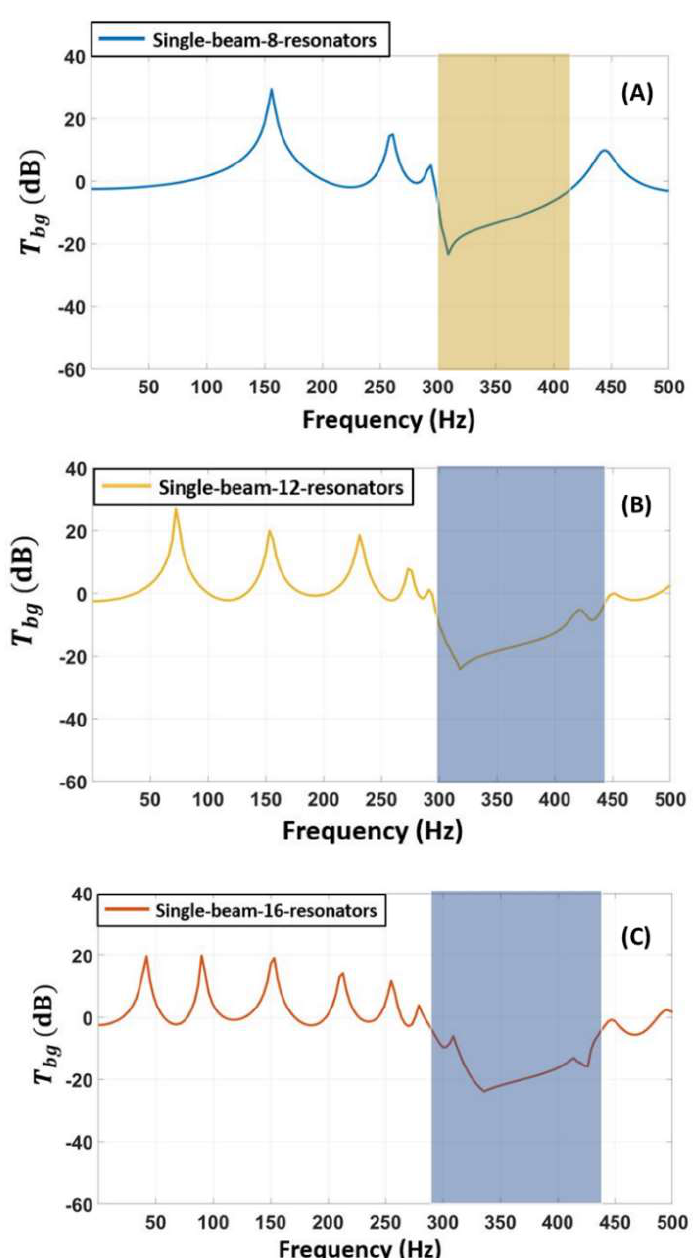
Figure 7. Transmissibility and frequency bandgaps of a single-beam metamaterial structure obtained using model simulations when the number of local resonators is increased: ( A ) A single-beam metamaterial structure with 8 local resonators; ( B ) a single-beam metamaterial structure with 12 local resonators; ( C ) a single-beam metamaterial structure with 16 local resonators.